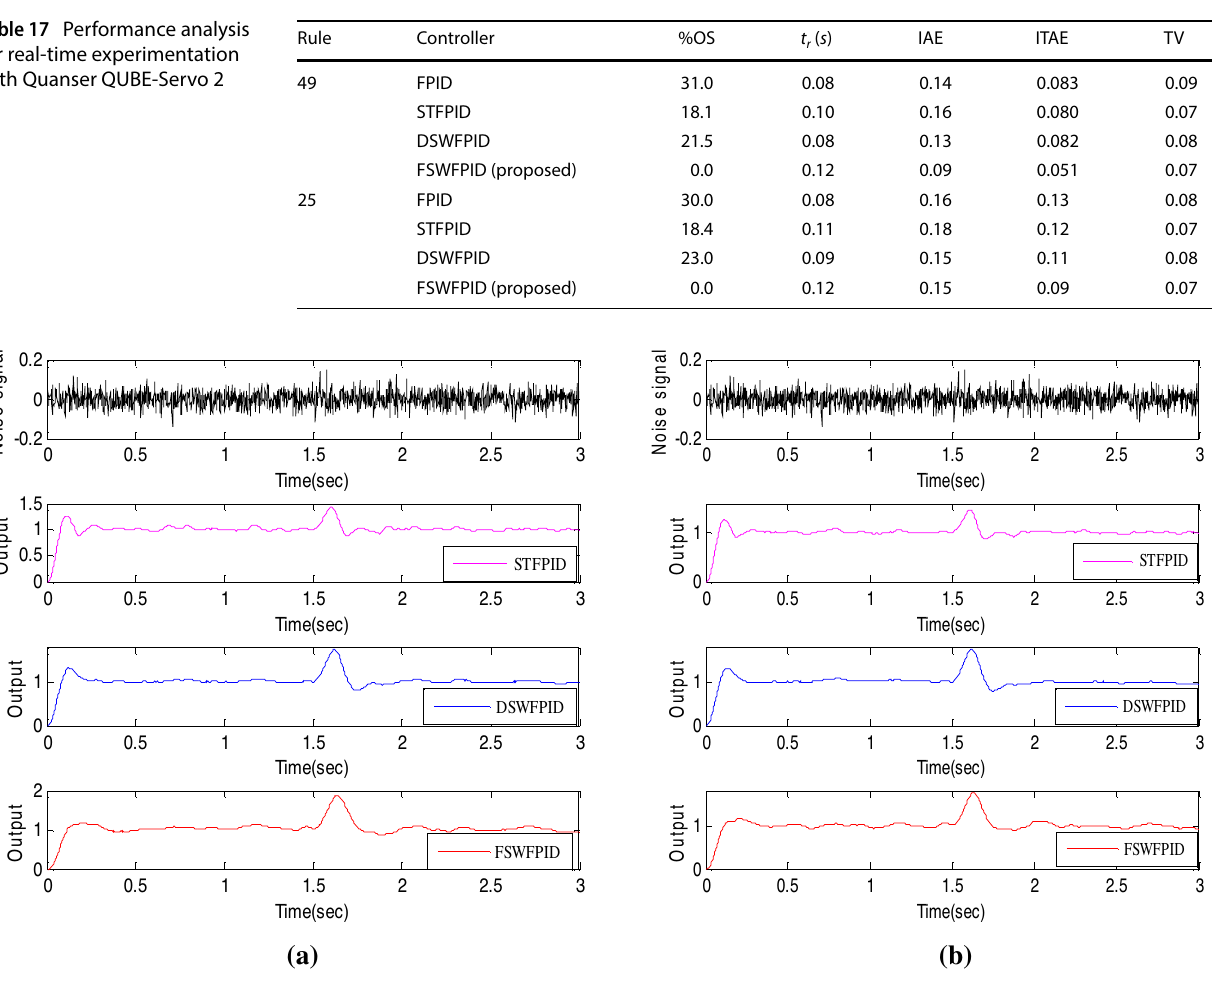
Fig. 27 Responses of Quanser QUBE-Servo 2 for STFPID, DSWFPID and FSWFPID along with noise signal for a 49 and b 25 control